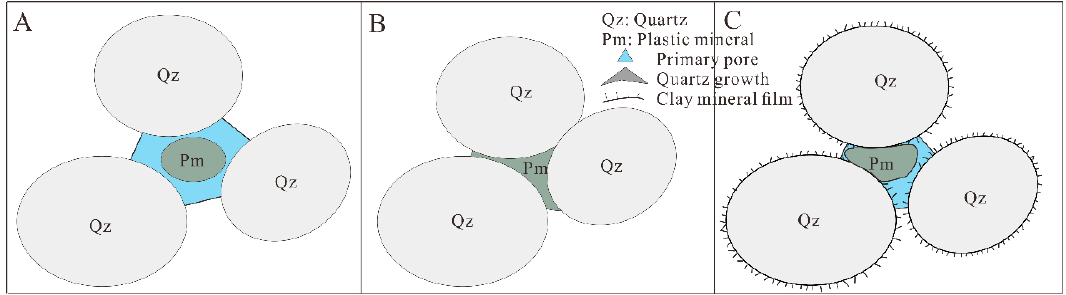
Figure 14. Influences of clay mineral rim on lithic quartz sandstone. ( A ) the primary intergranular pore of lithic quartz sandstone; ( B ) the primary intergranular pore filled by the plastic mineral or fake matrix; ( C ) the primary intergranular pore, preserved by the clay mineral rim, of the lithic quartz sandstone.